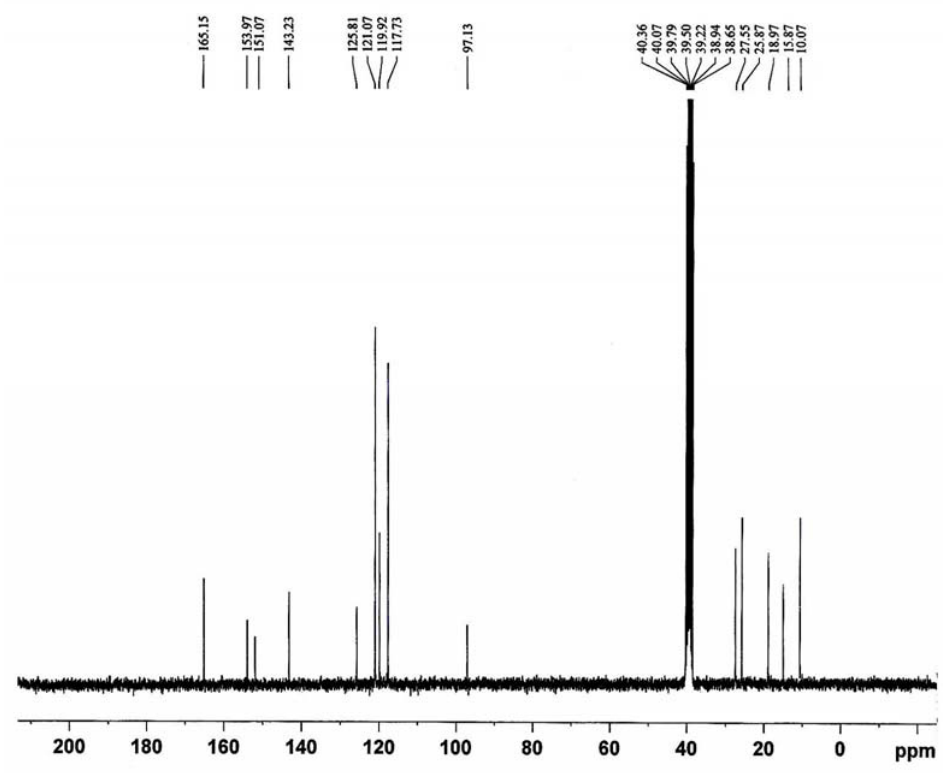
Figure 3. 13 C-NMR spectrum of the ligand